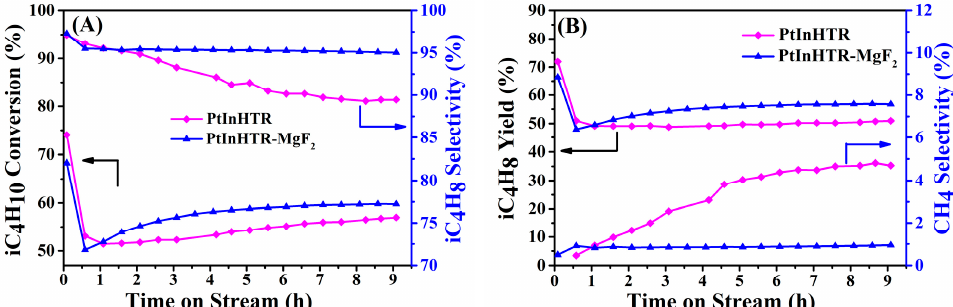
Figure 6. ( A ) Isobutane conversion and isobutene selectivity, ( B ) isobutene yield and by-product methane selectivity as functions of time. (Reaction conditions: 600 °C, 1 atm, H 2 :iC 4 H 10 = 1:1 (molar ratio), WHSV (iC 4 H 10 ) = 3 h − 1 , m cat = 0.5 g).